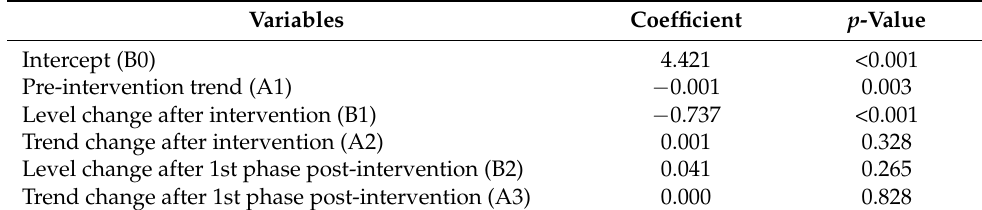
Table 3. Changing trends and levels of mean dosing frequency per day (count).